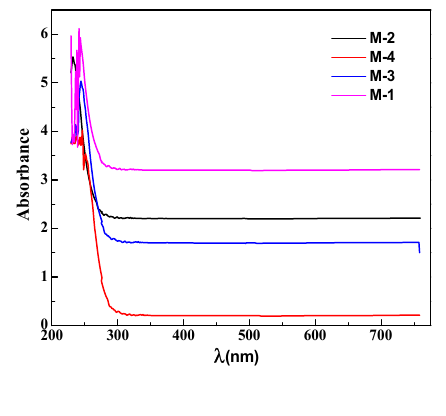
Figure 4 : UV/VIS optical absorption spectra of ZnSe/PVA